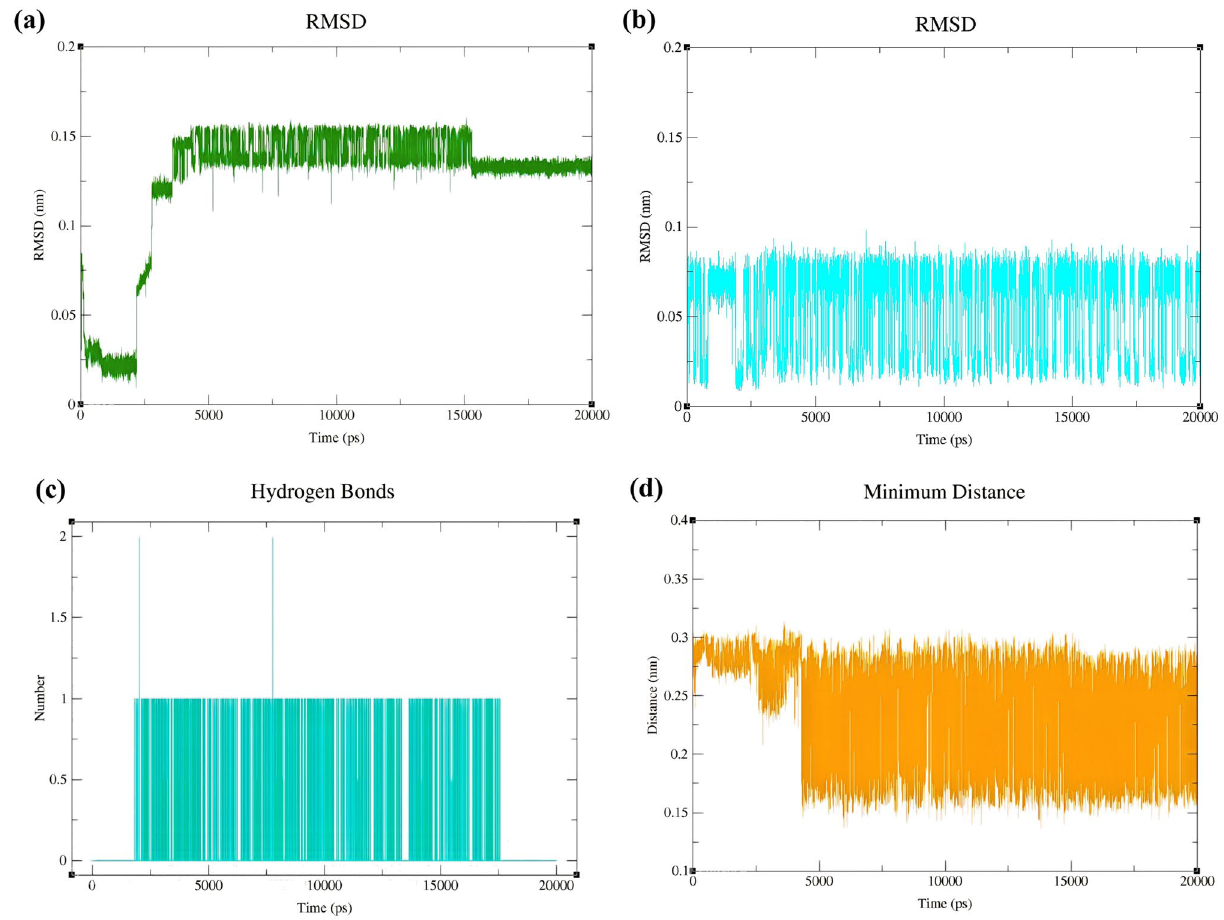
Figure 5. GTA backbone RMSD (a) and IBU backbone RMSD (b) in the structure of [(GTA) (IBU)] IL. (c) Intermolecular hydrogen bonds between GTA and IBU during 20 ns of MD simulation, (d) the patterns of